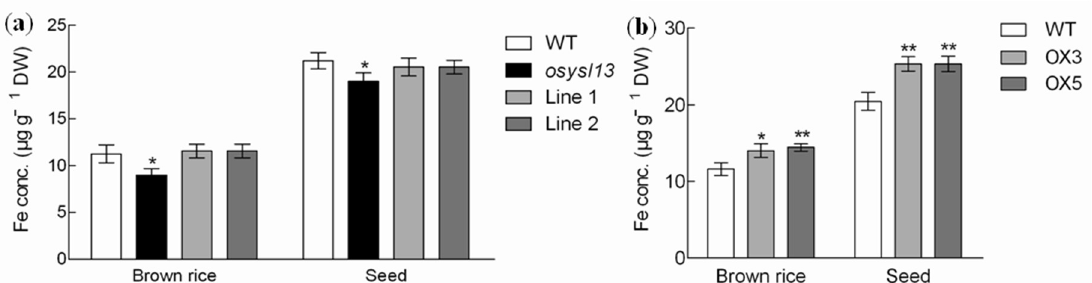
Figure 7. Fe concentrations analysis at the reproductive stage. ( a ) Fe concentrations in the brown rice and seeds of the osysl13 mutant, wild-type, and complementation lines. ( b ) Fe concentrations in the brown rice and seeds of OsYSL13 overexpression lines and wild type. Seeds were harvested from rice grown in soil. Fe concentrations were determined by ICP-MS. Significant differences compared with the wild type were determined by ANOVA (* p < 0.05 and ** p < 0.01). Data were shown as means ± SD ( n = 3). DW, dry weight.